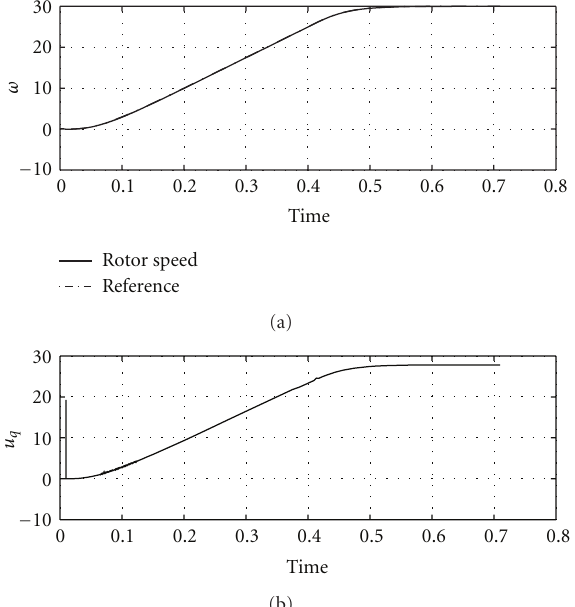
Figure 1: Transient behavior of the output and control input.